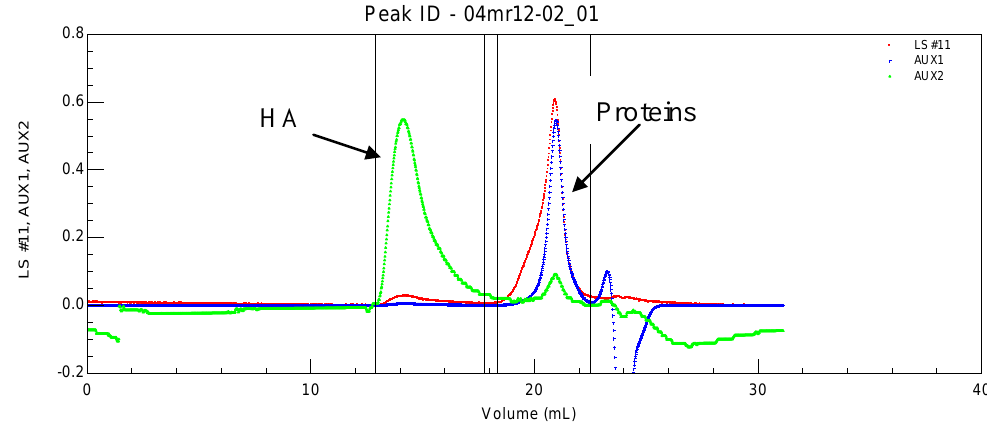
Figure 1. SEC chromatogram of a synovial fluid allowing the determination of soluble proteins and HA molecular weights and their concentrations. T = 30 °C, eluent 0.1 M NaNO . LS is the light scattering signal (red); AUX 1 is the refractive index signal (blue); 3 AUX 2 is the viscometric signal (green).